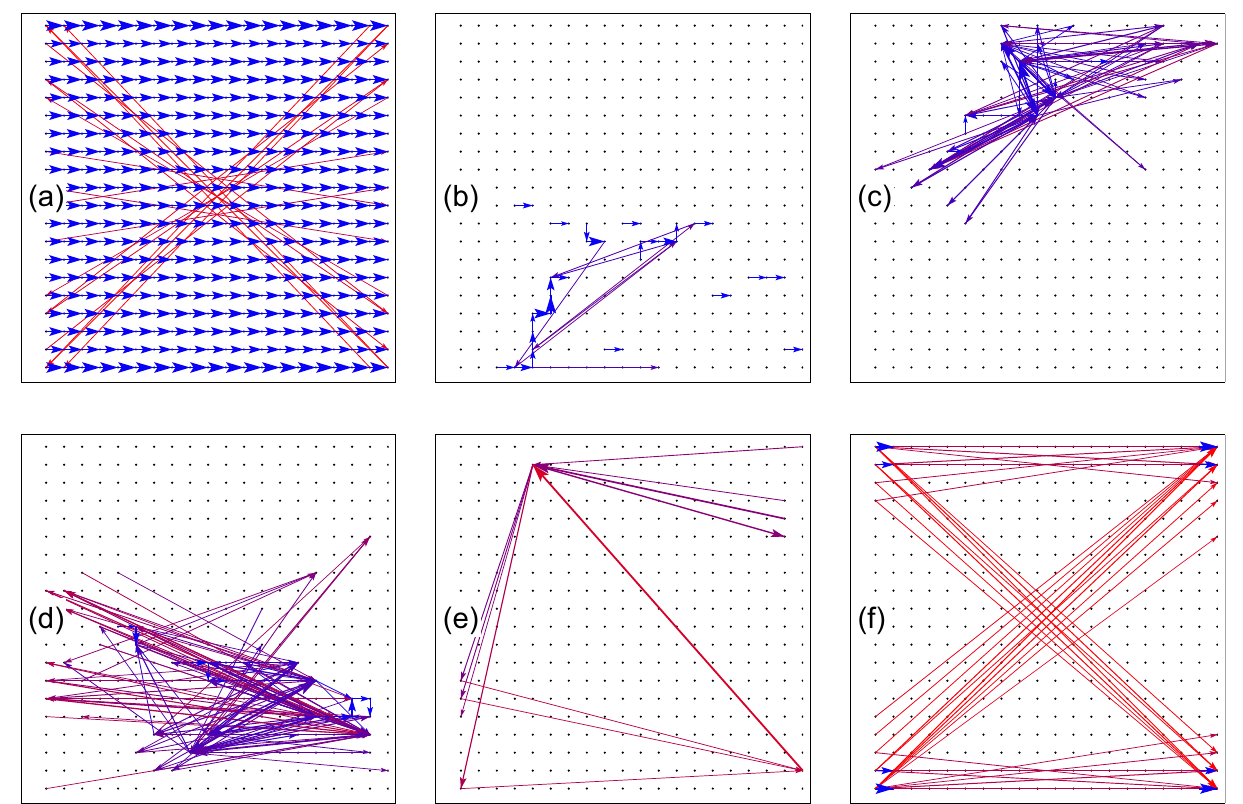
Figure 4. (Color online) Distribution of bond currents for a certain disorder configuration on a 20 × 20 lattice, with the source (drain) lead connected to the left (right) boundary. ( a )–( e ): Fermi energy E = 1 in the band, with disorder strength W = 0, 3, 5, 7, 11 , respectively. ( f ): Sample Fermi energy E = 203.71 at the EIS, with W = 7 , discussed in Section IV. Each arrow connecting two sites represents the corresponding bond (thus its length indicating the bond length), with the size of the arrowhead alone to indicate the magnitude of its current. For visual clarity, only currents with J ≥ 0.4 J max are displayed, and long (short) bonds are plotted in red (blue) color, while intermediately long bonds in purple